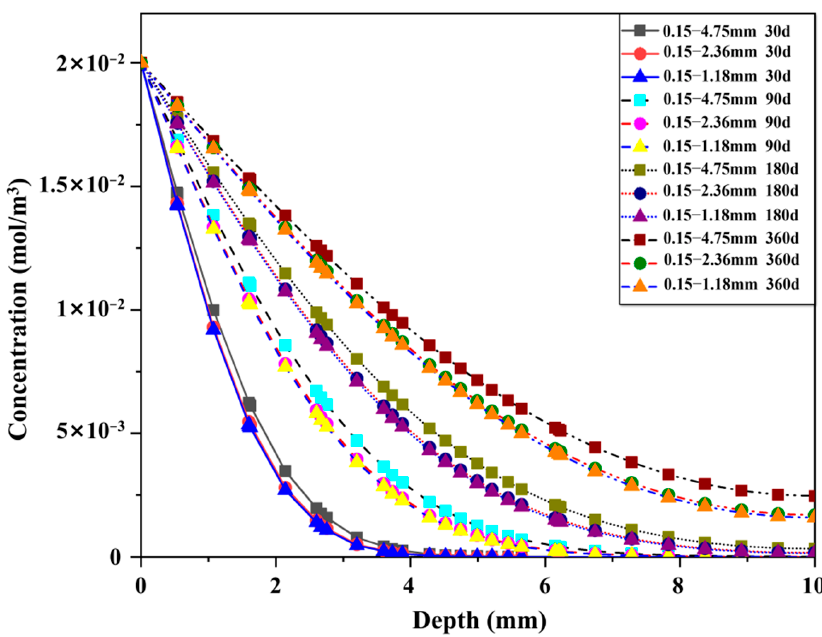
Figure 6. Effect of LWA particle size on chloride ion transport in L-UHPC under different erosion age.